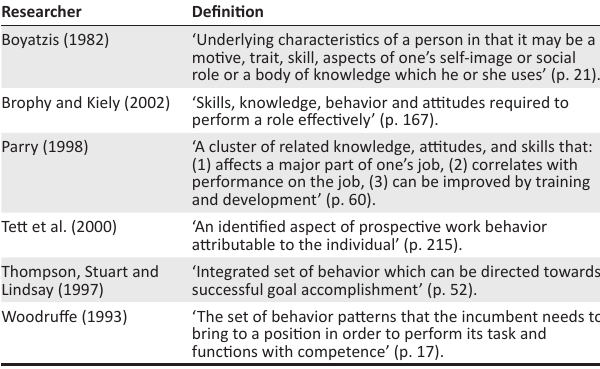
TABLE 1: Definitions of